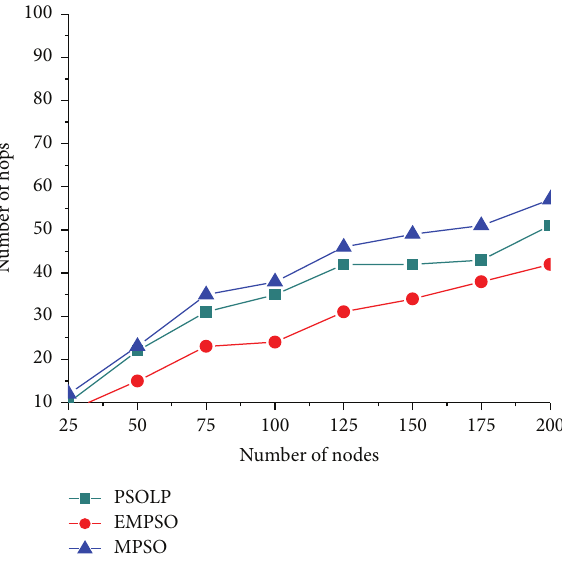
Figure 9: Number of hops versus number of